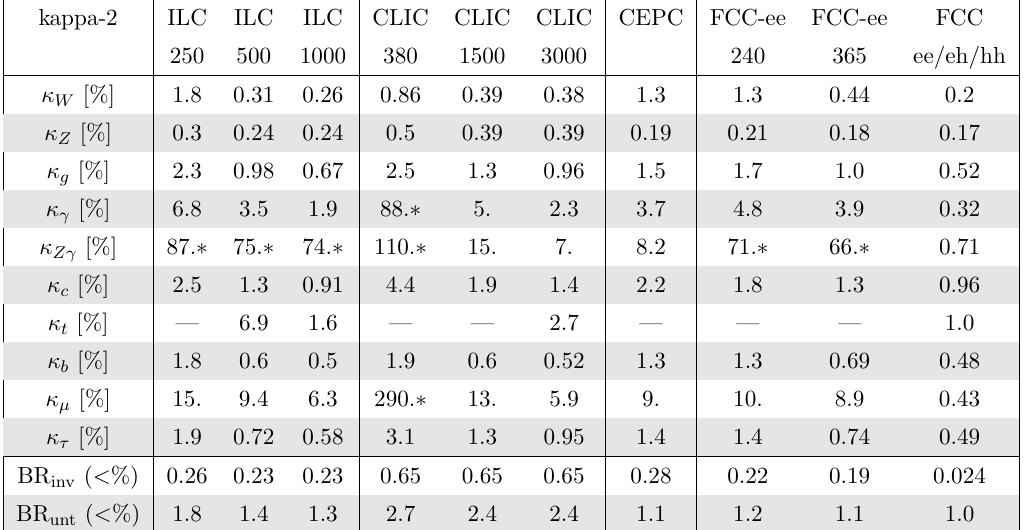
Table 29 . Expected relative precision (%) of the (cid:20) parameters in the kappa-2 (standalone collider) scenario described in section 2 for future accelerators beyond the LHC era. The corresponding 95%CL upper limits on BR unt and BR inv and the derived constraint on the Higgs width (in %) are also given. Cases in which a particular parameter has been (cid:12)xed to the SM value due to lack of sensitivity are shown with a dash (-). An asterisk ( (cid:3) ) indicates the cases in which a parameter has been left free in the (cid:12)t due to lack of input in the reference documentation. The integrated luminosity and running conditions considered for each collider in this comparison are described in table 1. FCC-ee/eh/hh corresponds to the combined performance of FCC-ee 240 +FCC-ee 365 , FCC-eh and